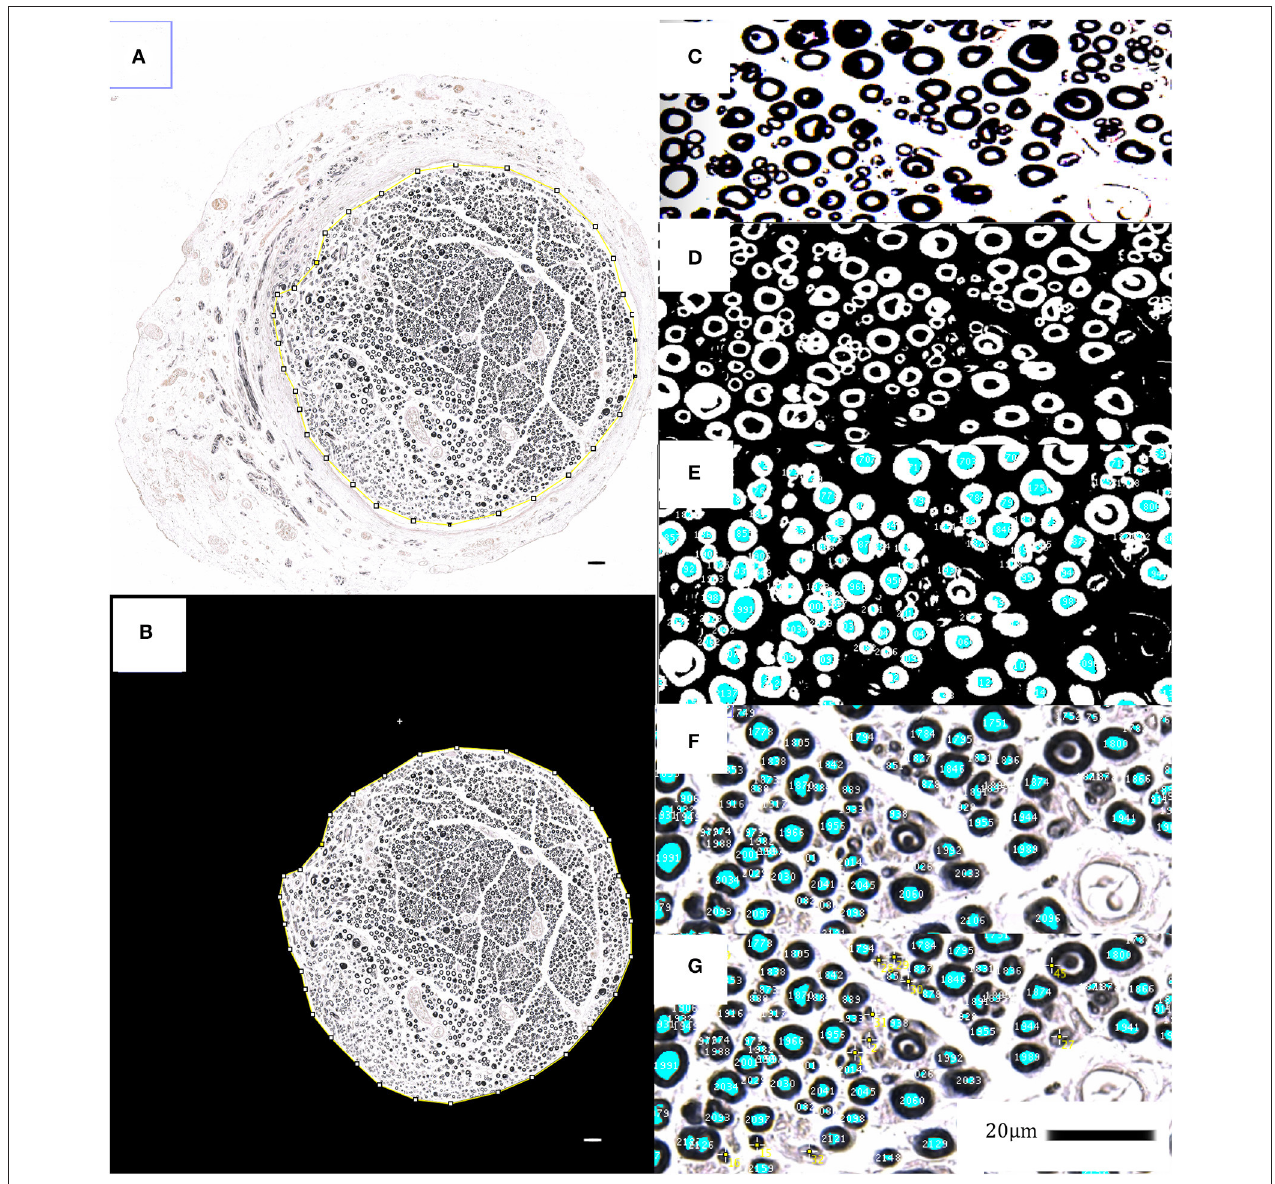
FIGURE 3 | Histomorphometrical analyses; (A–G) show the applied semi-automatic algorithm via ImageJ for myelinated axon- and fascicle area detection and measurement in osmium tetroxide stained, paraffin embedded nerve cross sections. The fascicle area is isolated and analyzed in order to identify, tag and simultaneously count the black-stained myelin sheaths via synopsis of color thresholds, particle size and –circularity. The identified myelinated axons are displayed as an overlay-mask, which has been carefully checked for its sensitivity and specificity regarding axon identification. Untagged axons were manually selected and added to the overlay (yellow tags). 20 µ m scale bars are